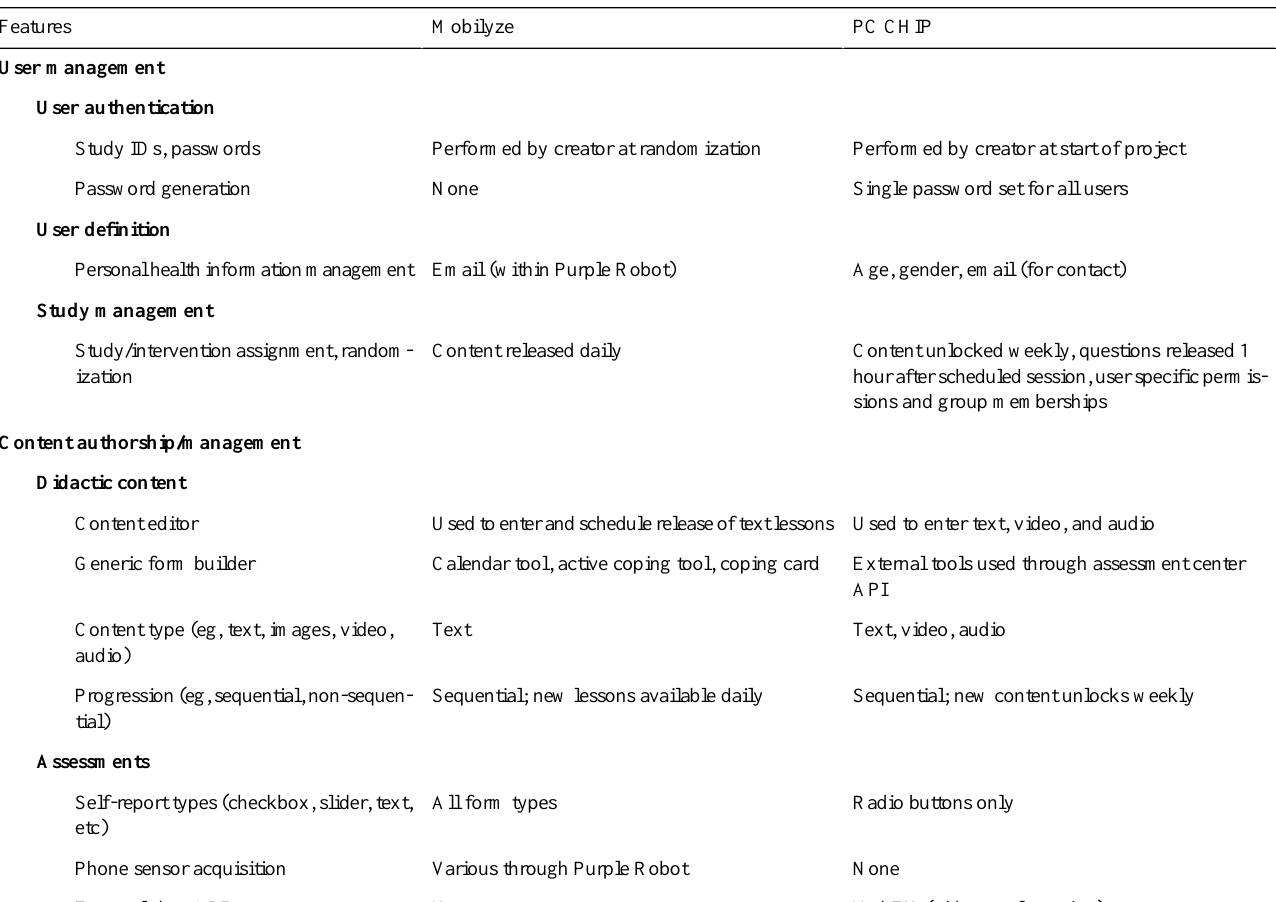
Table 2. Technical features within intervention case